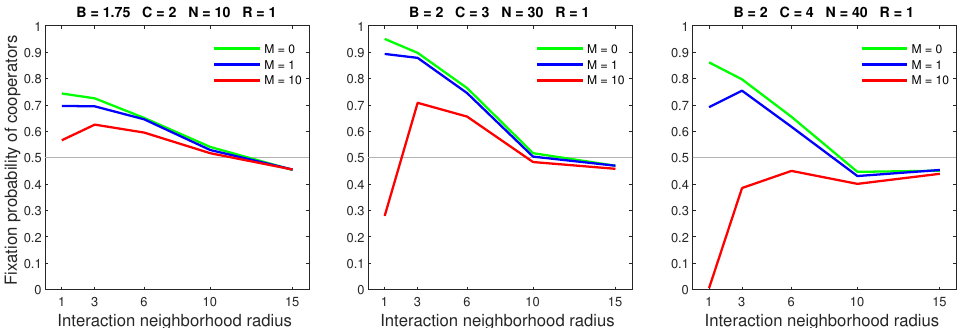
Figure 4. In the random dispersal model, increasing the mobility rate is detrimental to cooperators. An increased rate is particularly harmful to cooperators in small neighborhoods with a low benefit– to–cost